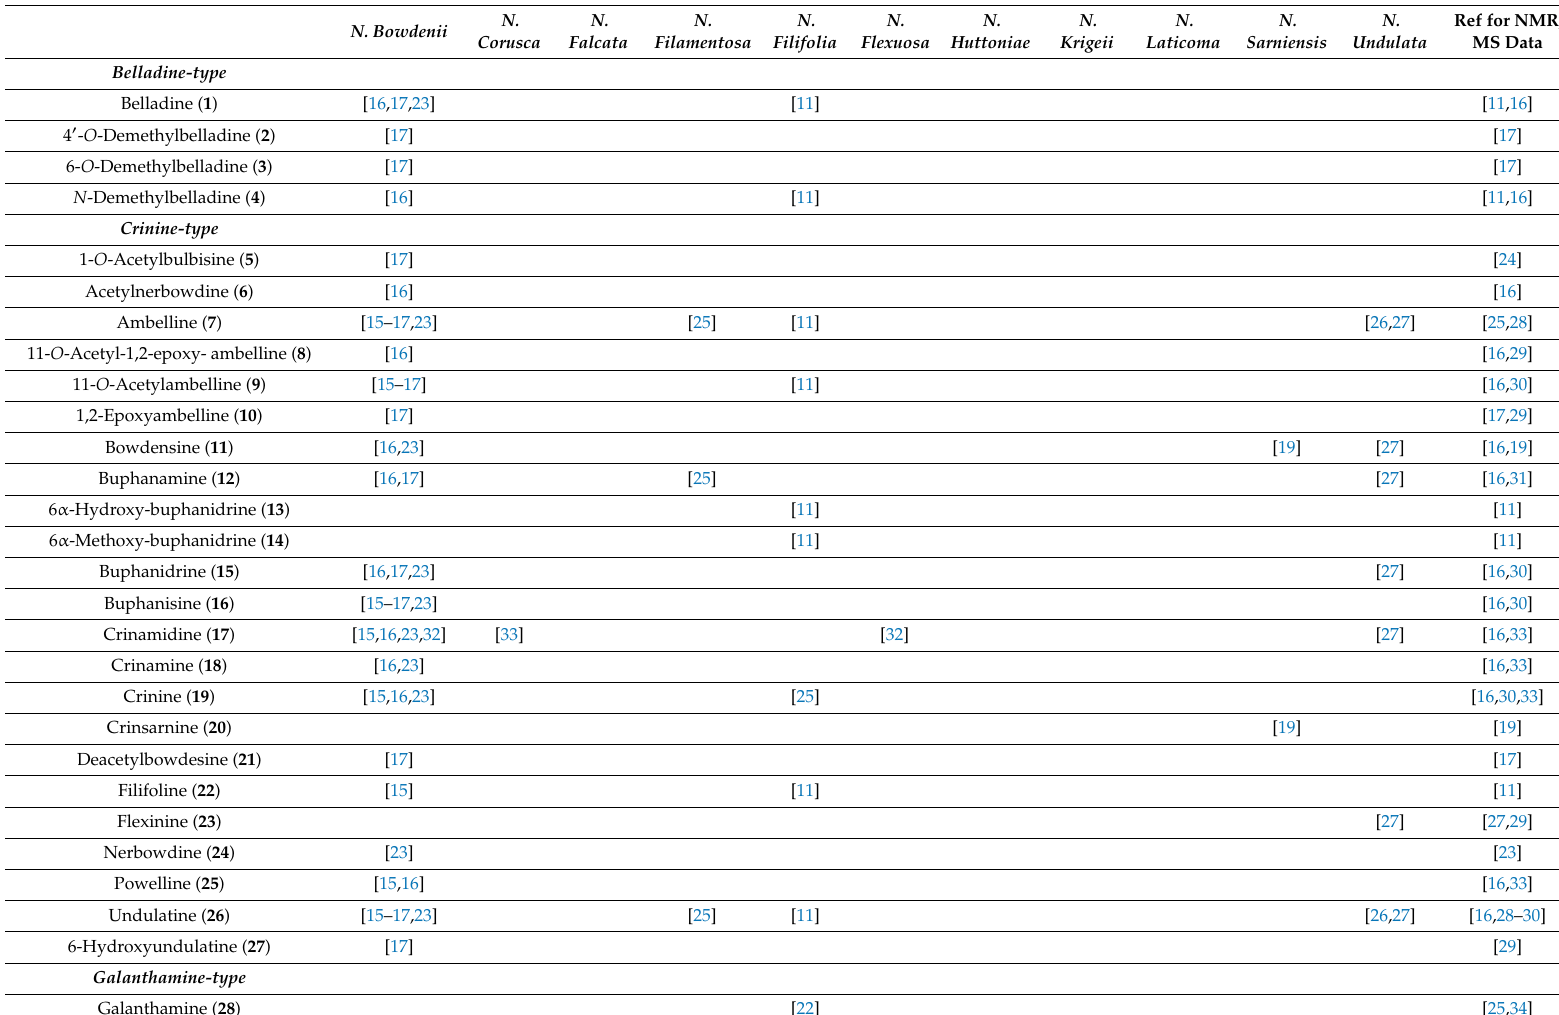
Table 1. Alkaloids reported in the genus